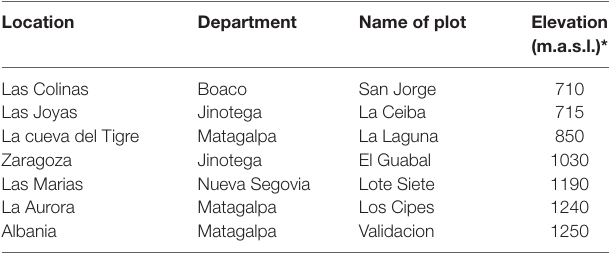
TABLE 1 | List of parcel locations where the hybrid Starmaya cultivar was tested in multi-environment trials in Nicaragua.